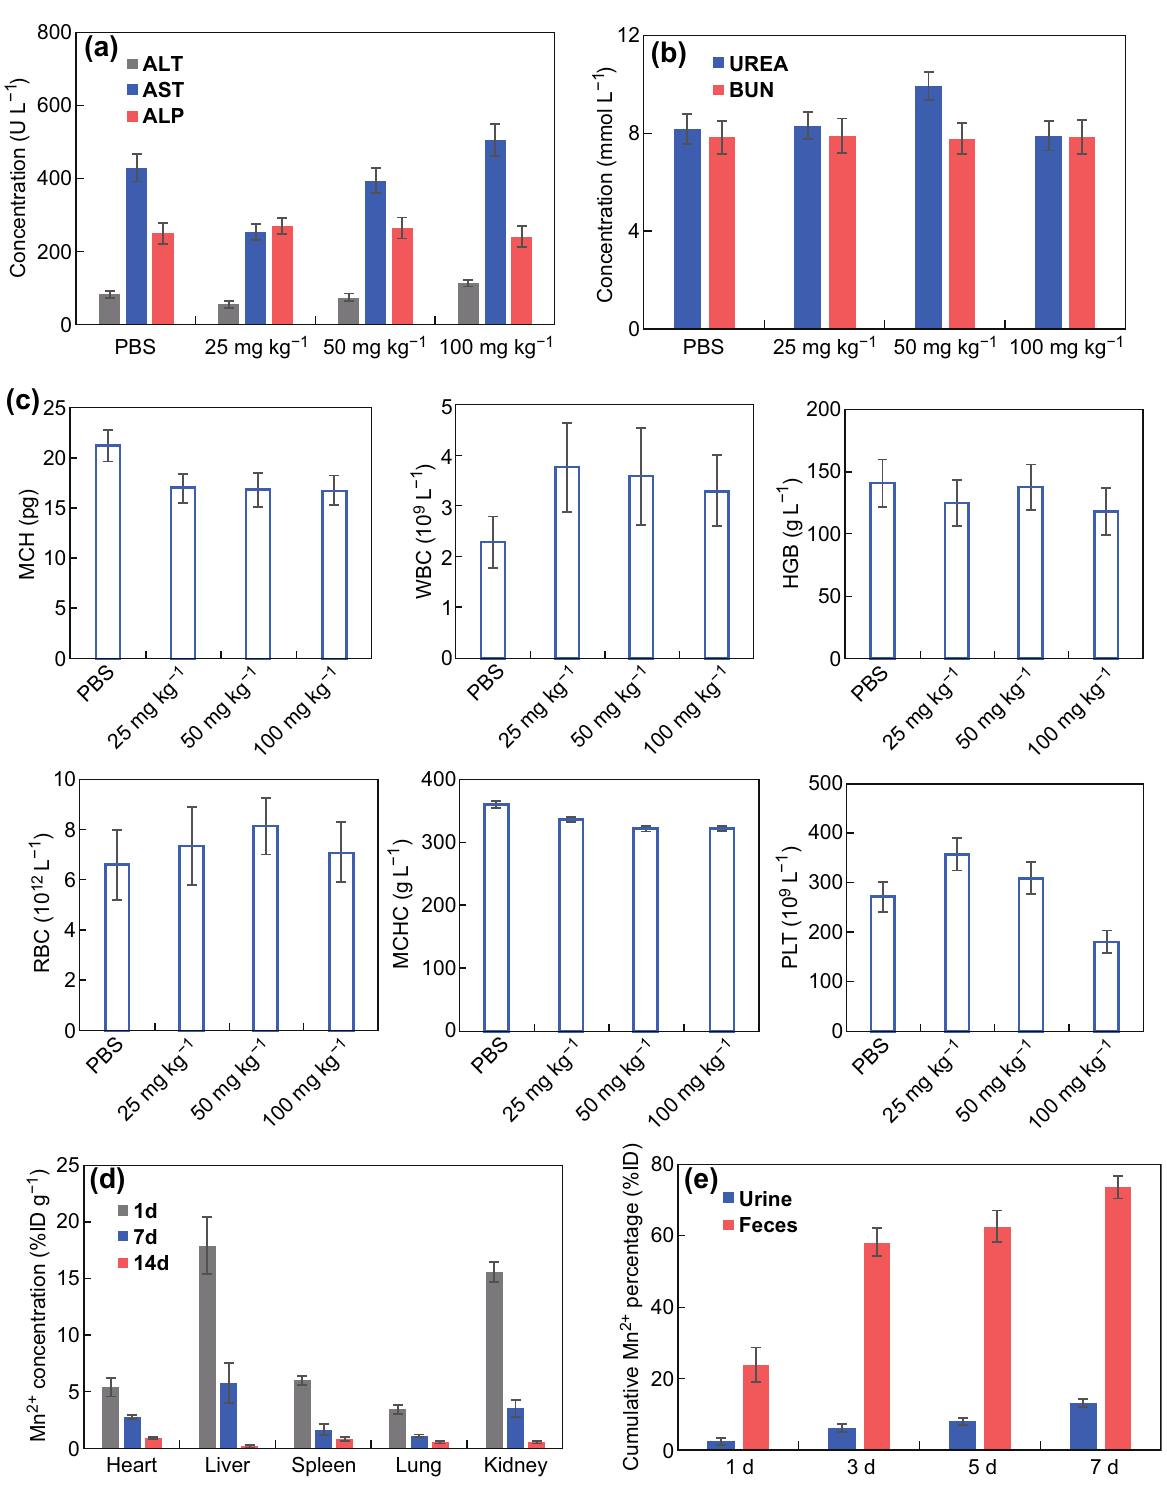
Fig. 4 a , b Serum biochemistry data of healthy mice after intravenous injection of APT-Mn-ZIF-90 for 7 days at different concentrations; c blood routine analysis. Blood levels of MCH, WBC, HGB, RBC, MCHC, and PLT of healthy mice after APT-Mn-ZIF-90 injection after 7 days at different concentrations; d biodistribution and e excretion profiles of Mn 2+ after treatment with APT-Mn-ZIF-90 at different times. Mean ±